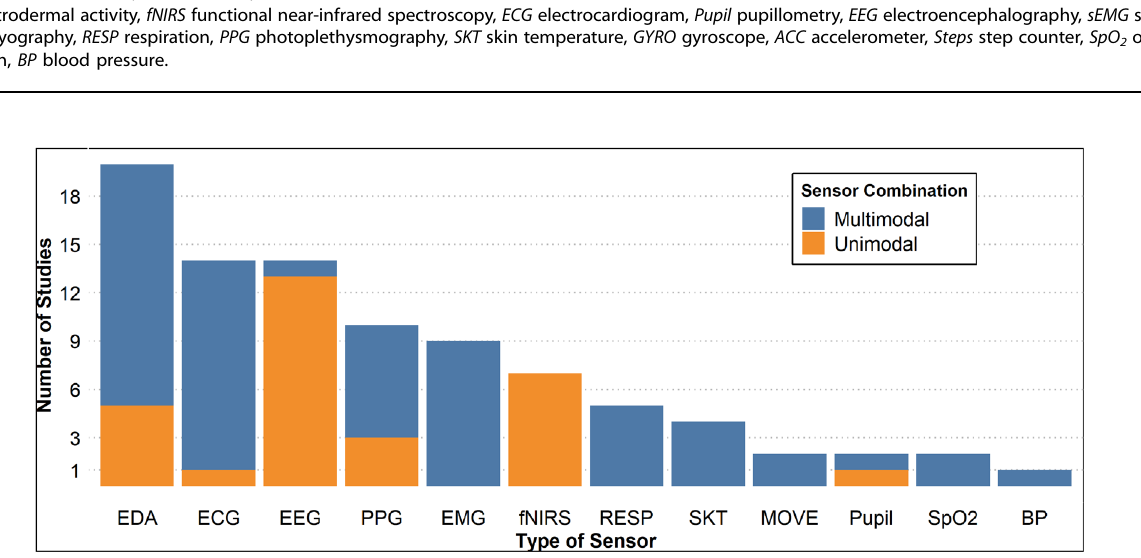
Fig. 2 Summary of type of sensors used in the reviewed literature. EDA electrodermal activity, ECG electrocardiogram, EEG electroencephalography, PPG photoplethysmography, EMG electromyography, fNIRS functional near-infrared spectroscopy, RESP respiration, SKT skin temperature, MOVE gyroscope/accelerometer/steps, Pupil pupillometry, SpO 2 oxygen saturation, BP blood